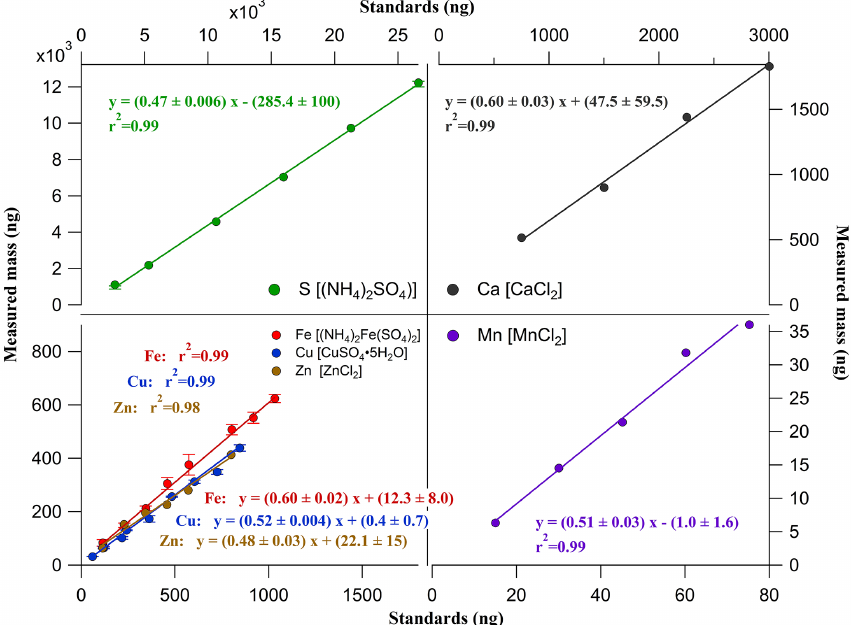
Figure 2. System calibration based on multiple element-ion standard solutions. Error bars represent the standard deviation of three replicates. Slopes and intercepts are based on orthogonal regression with errors as 1 standard deviation. Table 1. Limits of detection (LOD), blanks ( N > 40) and uncertainties for all water-soluble elements. Element LOD, Blank, Analytical Sum of square of Uncertainty from Overall ngm − 3 ngm − 3 uncertainty, % various uncertainties, % collocated measurements, % uncertainty, % Sulfur (S)